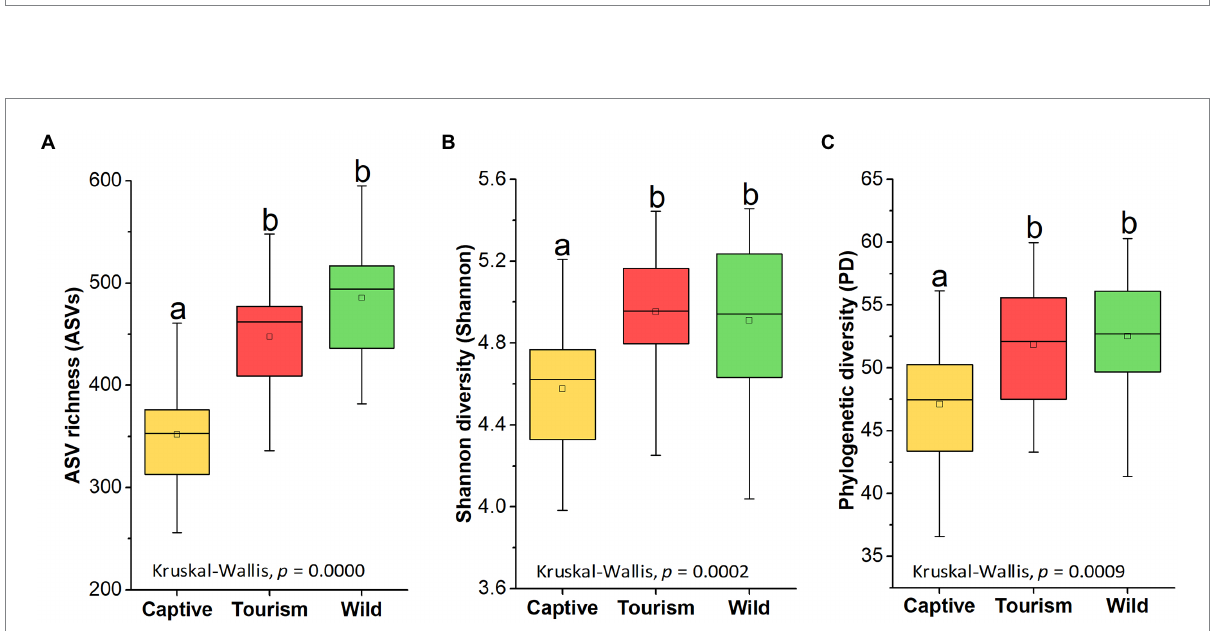
FIGURE 2 Variations on the alpha diversity in the gut microbiome among three study groups. A : Comparison of ASV richness. B : Comparison of Shannon diversity index. C : Comparison of PH diversity index. A Kruskal-Wallis test was used to evaluate the variation across three groups. Post-hoc tests (Tukey–Kramer test) for pairwise comparison tests ( p values were adjusted by FDR). Letters in (A) , (B) and (C) represent significant